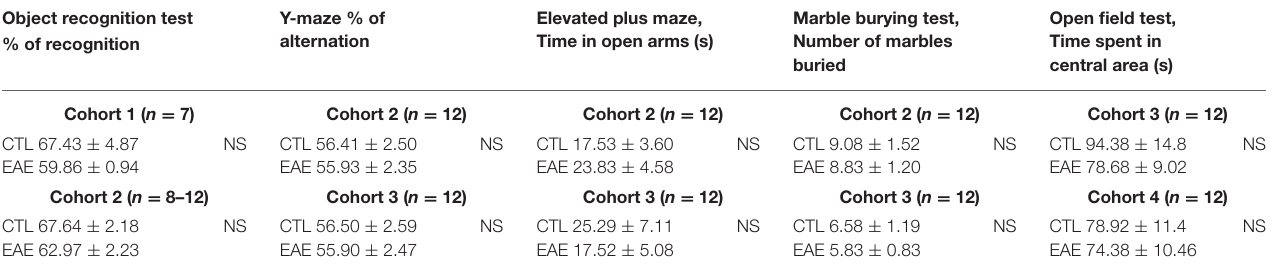
TABLE 3 | Summary table of cognitive tests performed in mice immunized with MOG 35 − 55 (QuilA-EAE) and their controls (CTL) during the chronic phase of the disease (D30). Object recognition test